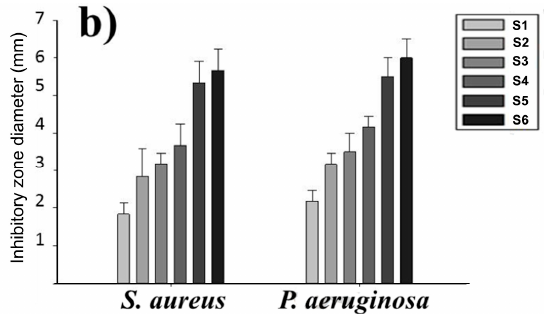
Figure 23. Images of S1, S2, S3, S4, S5 and S6 coated PCL mats showing ( a ) inhibition zones ( b ) zone diameters against S. aureus and P. aeruginosa . Reproduced with permission from [149]. Copyright Elsevier, 2018.